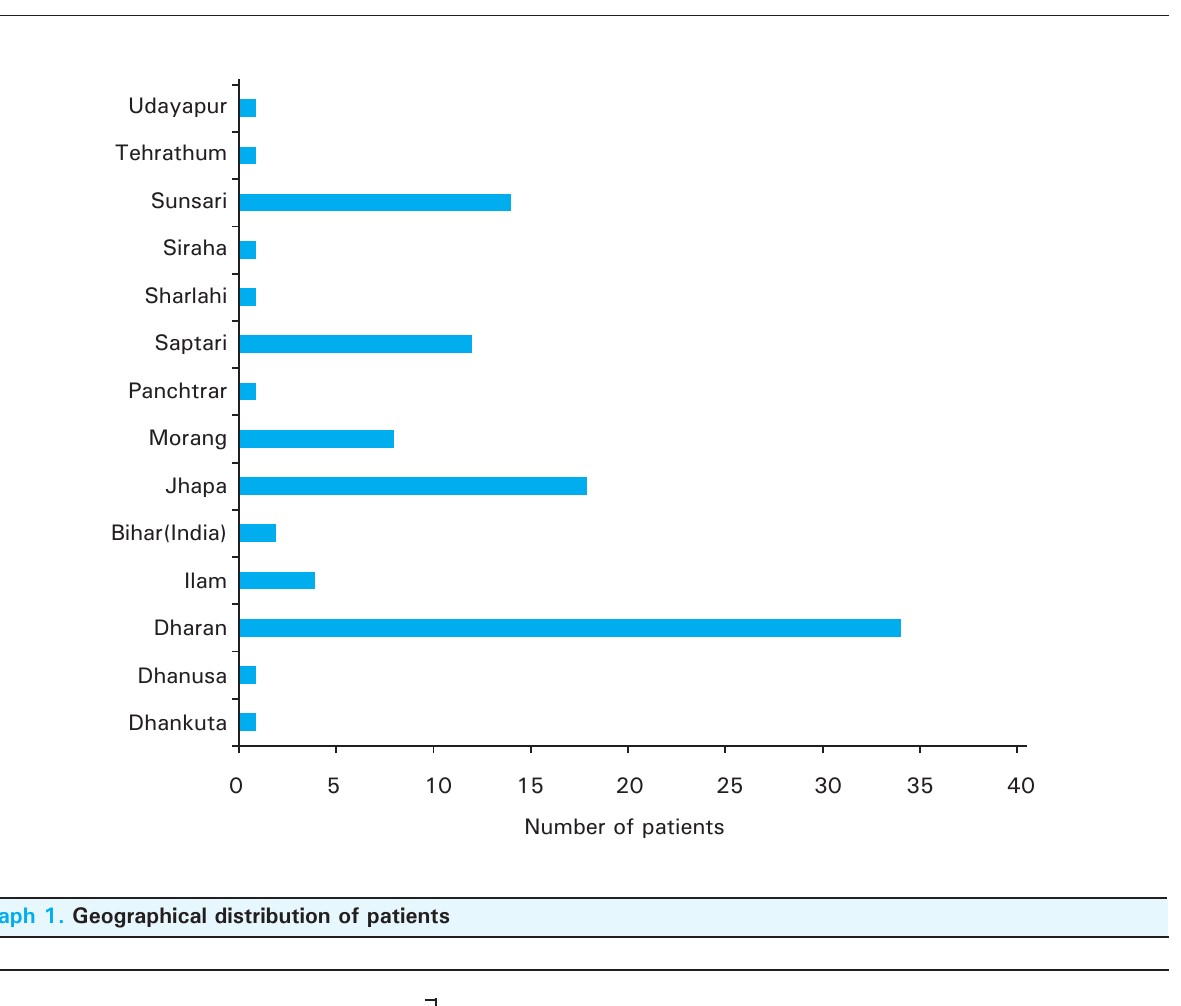
Graph 1. Geographical distribution of